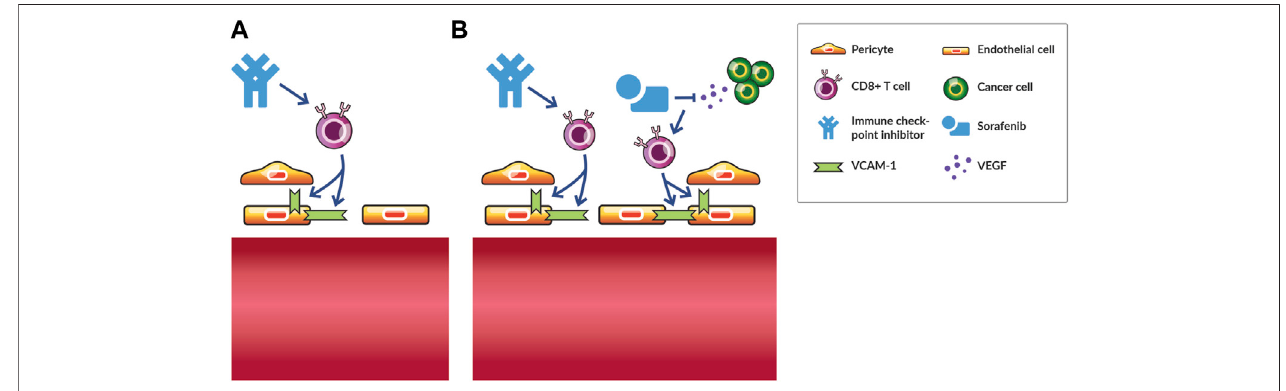
FIGURE 4 | Vascular forti fi cation by immune checkpoint inhibition promotes vascular normalization by subsequent antiangiogenic therapy in hepatocellular carcinoma. (A) Immune checkpoint inhibition monotherapy normalizes tumor blood vessels in various murine models of cancer by increasing the interaction between endothelial cells and with perivascular cells in a CD8 + T cell dependent manner. (B) Following immune checkpoint inhibition with antiangiogenic therapy, such as the small-molecule tyrosine kinase inhibitor sorafenib, increases the density of tumor blood vessels forti fi ed by pericytes and antitumor ef fi cacy in a CD8 + T cell dependent manner. In contrast, sorafenib monotherapy induces vascular regression and does not induce an antitumor effect. Thus, vascular-fortifying ICI can shift the effect of subsequent antiangiogenic therapy from vessel destruction to